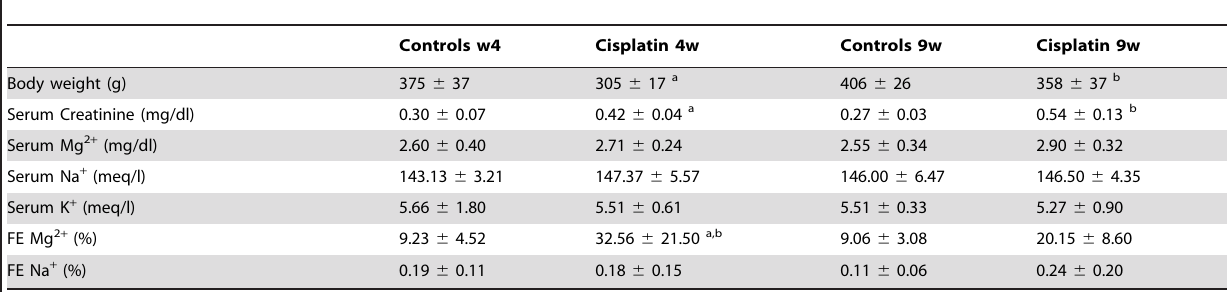
Table 1. Urine and serum analyses and body weight.